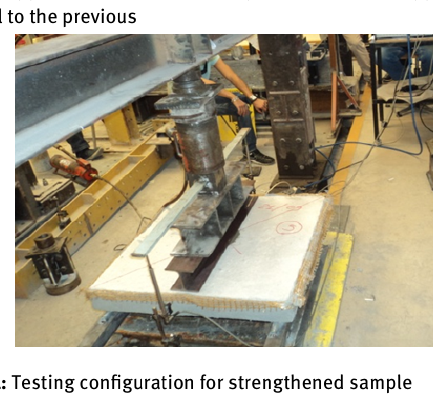
Figure 10: Drawing up of the second mortar layer 4 mm